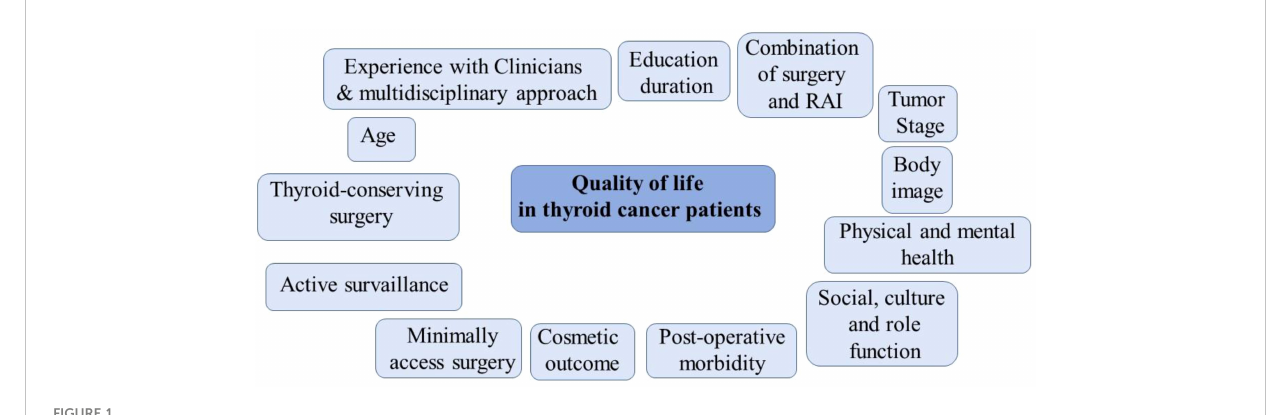
FIGURE 1 Factors in fl uencing quality of life in thyroid cancer